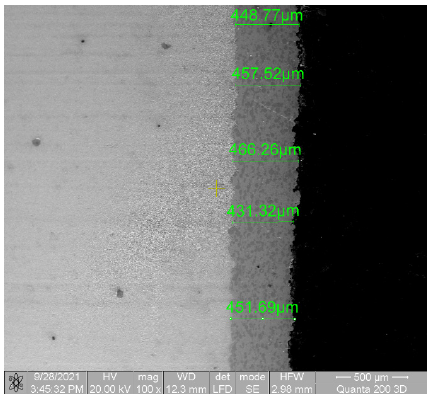
Figure 5. SEM image with cross-section at the interface between the base and the coated materials.